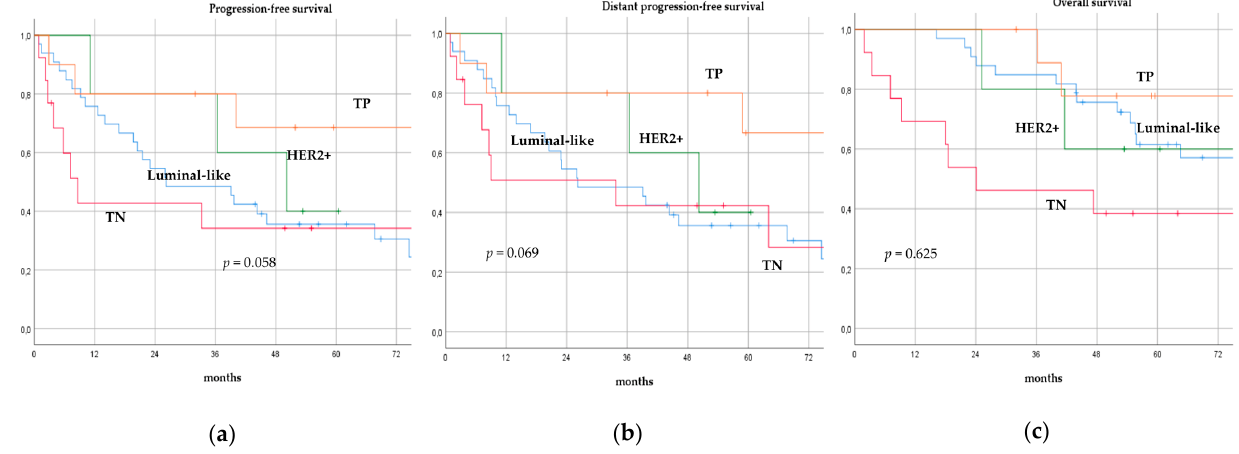
Figure 5. Progression-free survival ( a ), distant progression-free survival ( b ), and overall survival ( c ) curves of de novo metastatic breast cancer patients according to biological sub-type. TP: Triple- positive, HER2+: HER2-enriched, TN: